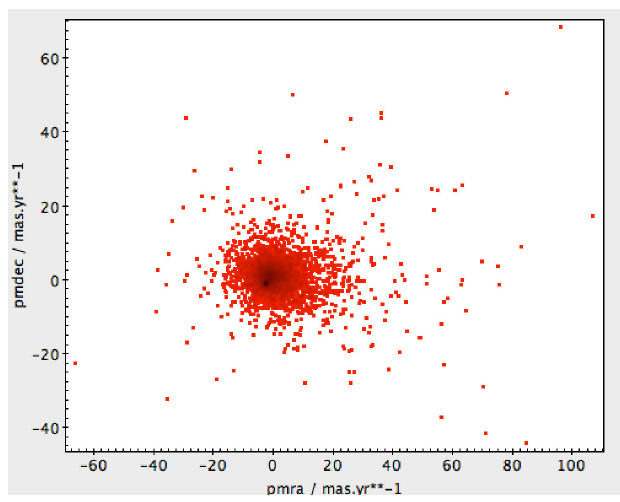
Fig. 63.— Proper motion plot of the region around NGC 188